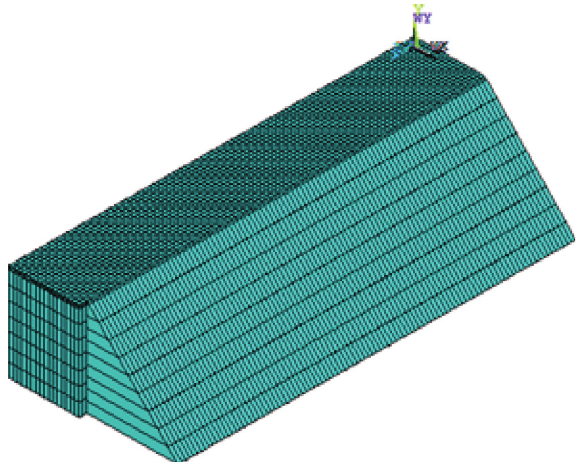
Figure 10: Finite element model of transition